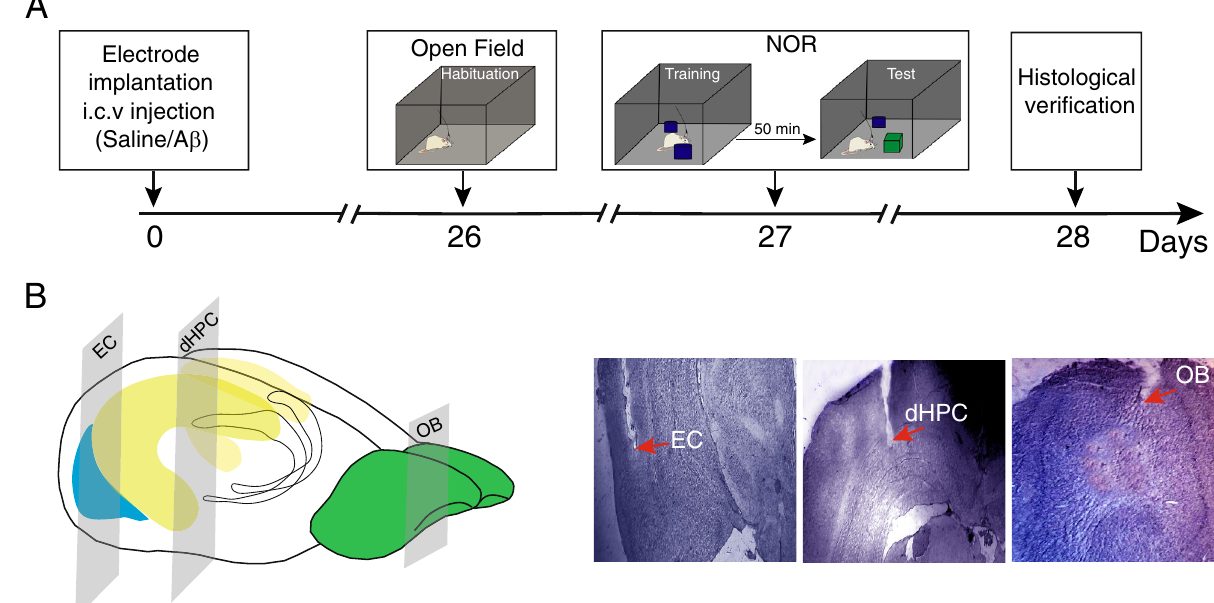
Figure 1. Experimental protocol and histological verification. ( A ) Schematic representation of the study timeline. Animals received bilateral i.c.v injection of saline or Aβ 4 μg in 2 μl. After recovery from surgery and model induction, animals were placed in the open field for habituation at day 26 and NOR task, with one day apart. ( B ) 3D view of electrode implantation sites on the brain and histological confirmation. i.c.v, intracerebroventricular; Aβ amyloid-beta, NOR novel object recognition, OB olfactory bulb, dHPC dorsal hippocampus, EC entorhinal